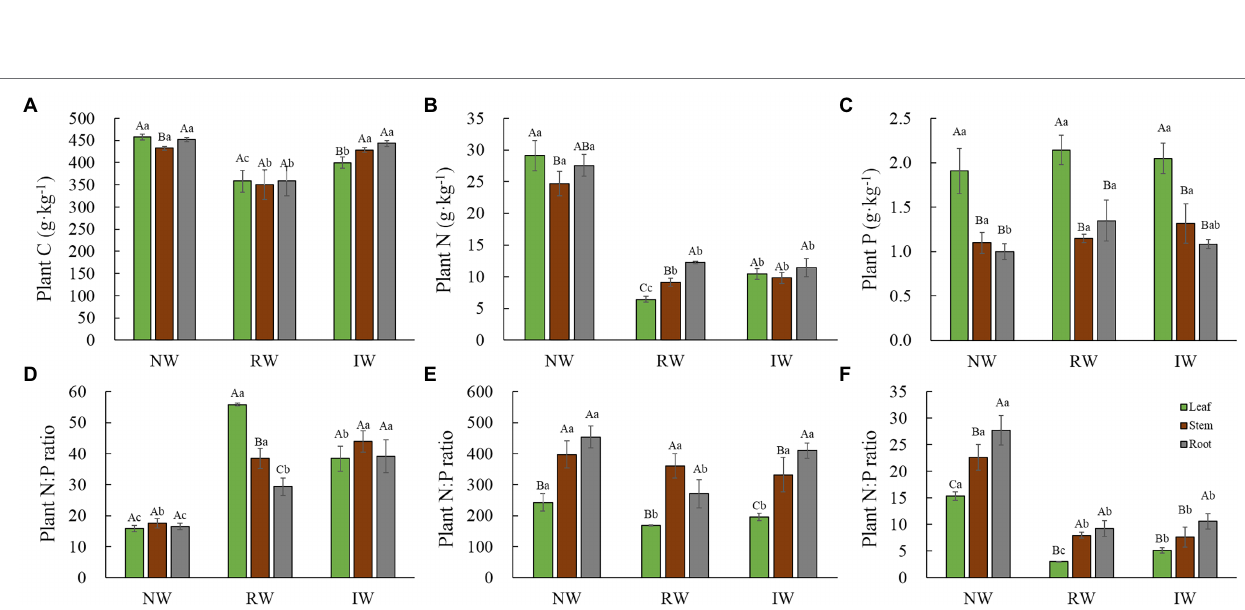
FIGURE 2 | Distributions of the plant Carbon (C) content (A) , plant N content (B) , plant P contents (C) , plant C:N ratio (D) , plant C:P ratio (E) , and plant N:P ratio ( F ; means ± SD, n = 3) under different land-use types in Hangzhou Bay. Different capital letters for the same land-use type indicate a significant difference among plant organs at p < 0.05, and different lower-case letters for the same organ indicate a significant difference among land-use types at p <